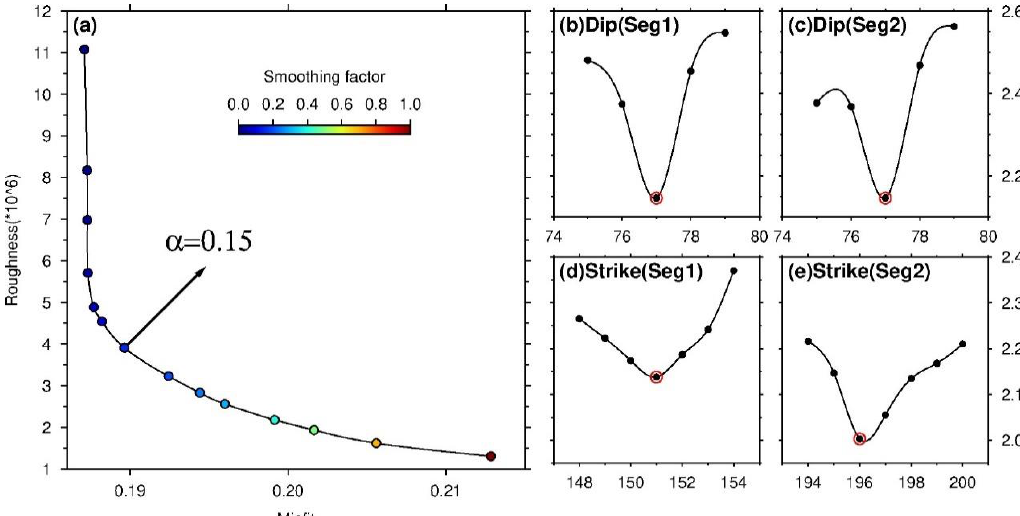
Figure 5. Search results of our preferred model. ( a ) Trade-off curve between the model roughness and misfit. Dips of the ( b ) main fault (Seg1) and ( c ) secondary fault (Seg2). Strikes of the ( d ) main fault (Seg1) and ( e ) secondary fault (Seg2).